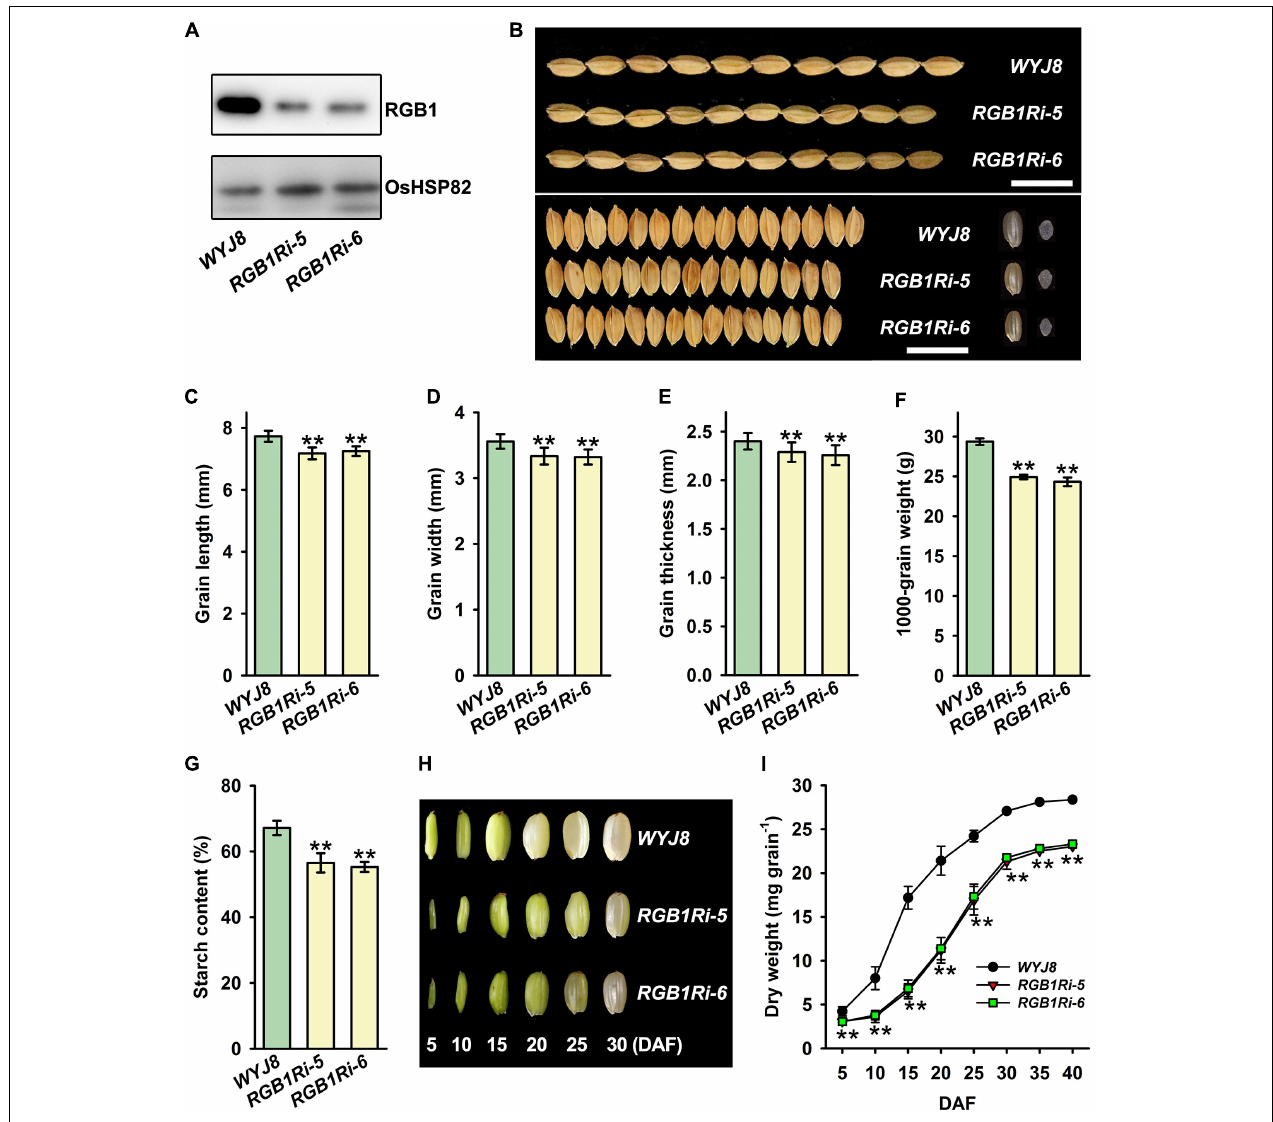
FIGURE 1 | Comparison of grain size and dry weight accumulation between wildtype ( WYJ8 ) plant and RGB1 RNA-interfered transgenic lines. (A) Immunoblot analysis of the transgenic plants. Total proteins are extracted from the panicles, and 10 µ g protein was used for western blotting. (B) Grain morphology (size and shape). Scale bar: 15 mm. (C–F) Comparison of grain size and weight between wild type ( WYJ8 ) and RGB1 RNA-interfered transgenic lines: (C) Grain length; (D) Grain width; (E) Grain thickness; (F) 1,000-grain weight. (G) The grain starch content. (H) The changes of caryopsis morphology at different days after flowering. (I) Changes in grain weight during grain-filling. Data are shown as means ± SD s ( n = 15). **Means significant differences when P <